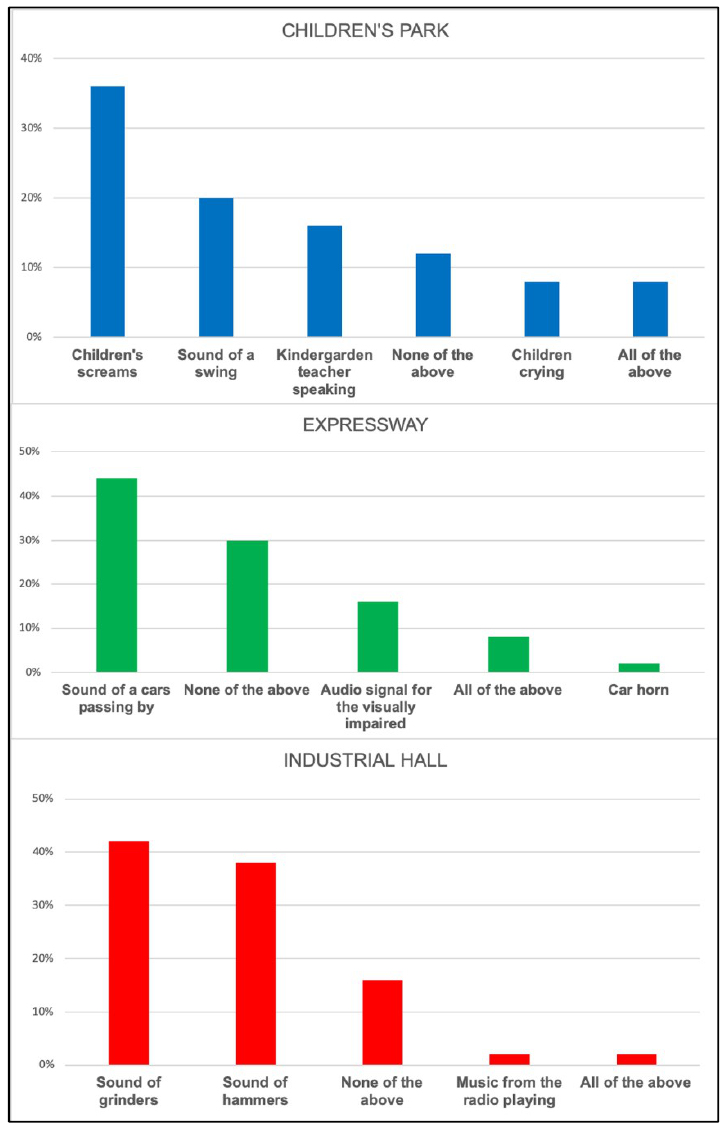
Figure 1. Short signals characterized by participants as distracting (based on [39]).